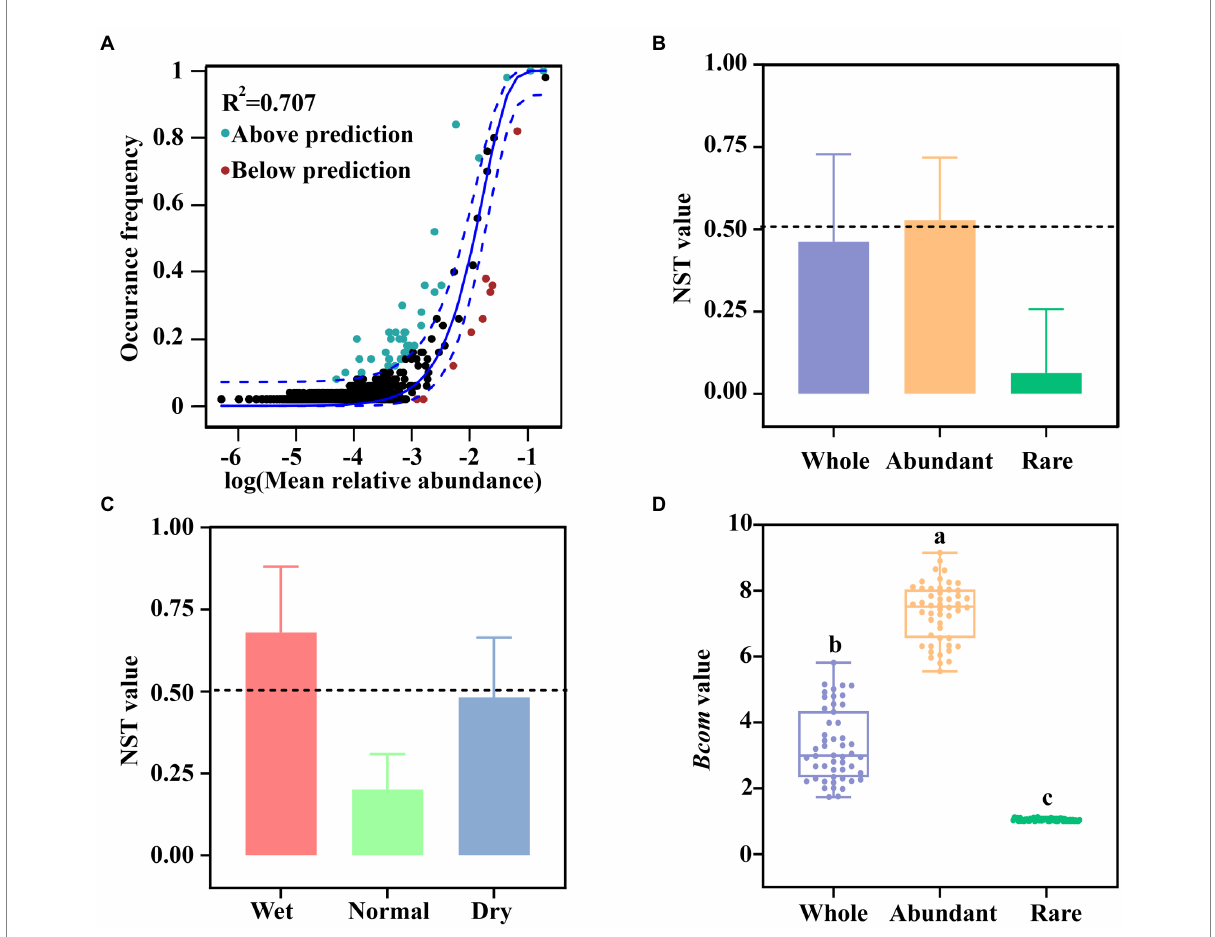
FIGURE 3 The assembly process and habitat niche breadth for whole, abundant, and rare DAMO bacterial communities. (A) Fit of the NCM model. The solid lines indicated the best fit to the NCM model, and the dashed lines represented 95% confidence intervals around the model prediction. ASVs that occurred more or less frequently than predicted by the NCM model were shown in green and red colors, respectively. R 2 indicated the fit to this model. (B) The assembly process for whole, abundant, and rare DAMO bacterial communities based on NST values. (C) The assembly process of DAMO bacterial communities during wet, normal, and dry seasons. (D) Boxplot showing Bcom values for whole, abundant, and rare DAMO bacterial communities. Different letters indicated significant difference ( p < 0.001, Duncan